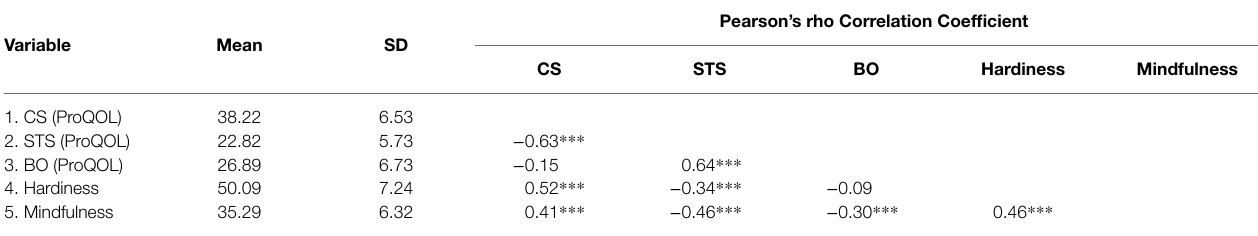
TABLE 3 | The correlation between the underlying factors of ProQOL, mindfulness, and hardiness among nurse ( n = 239).